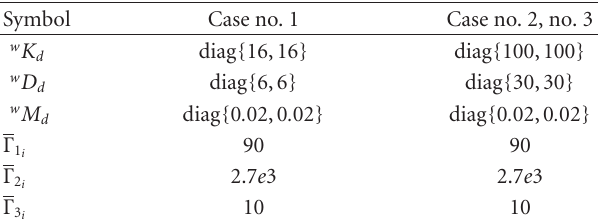
Table 2: Parameters of the three-link planar manipulator controller used in the simulations.